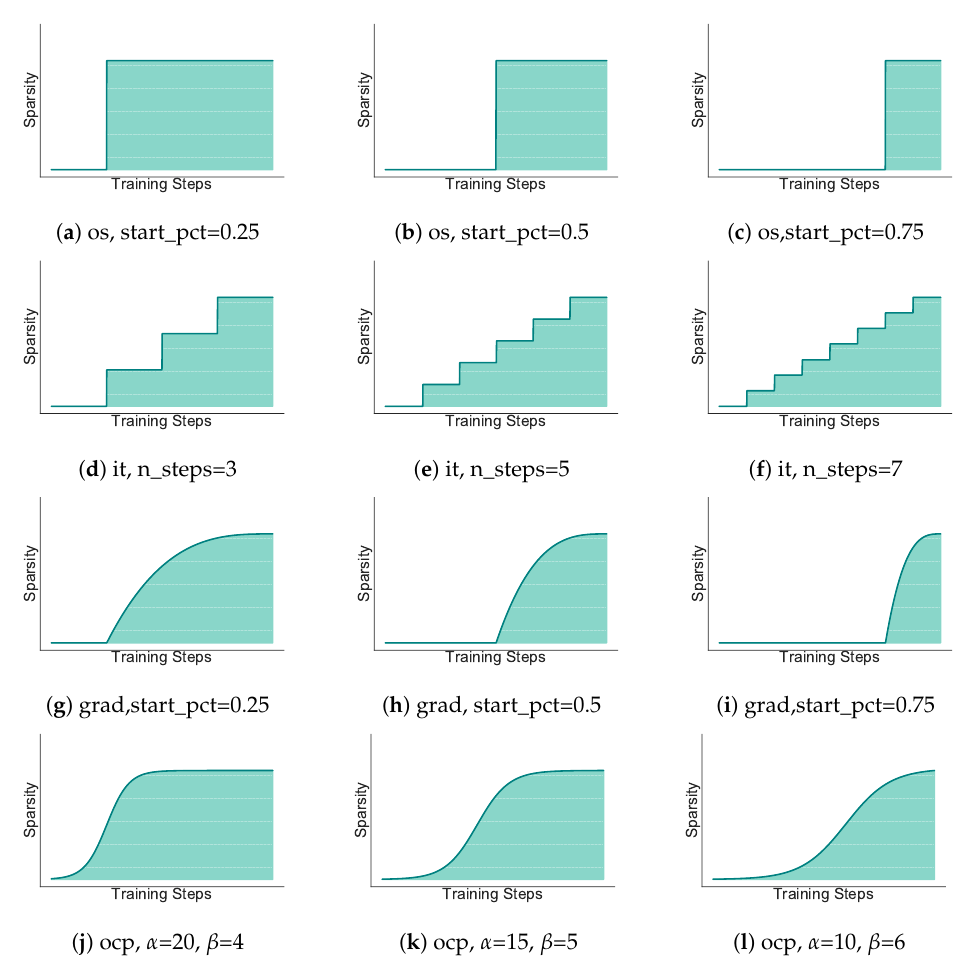
Figure 4. Evolution of sparsity along training for the available pruning schedules. While the sched_func parameters defines the general evolution, the schedule can further be customized by modifying the start_pct and end_pct values.